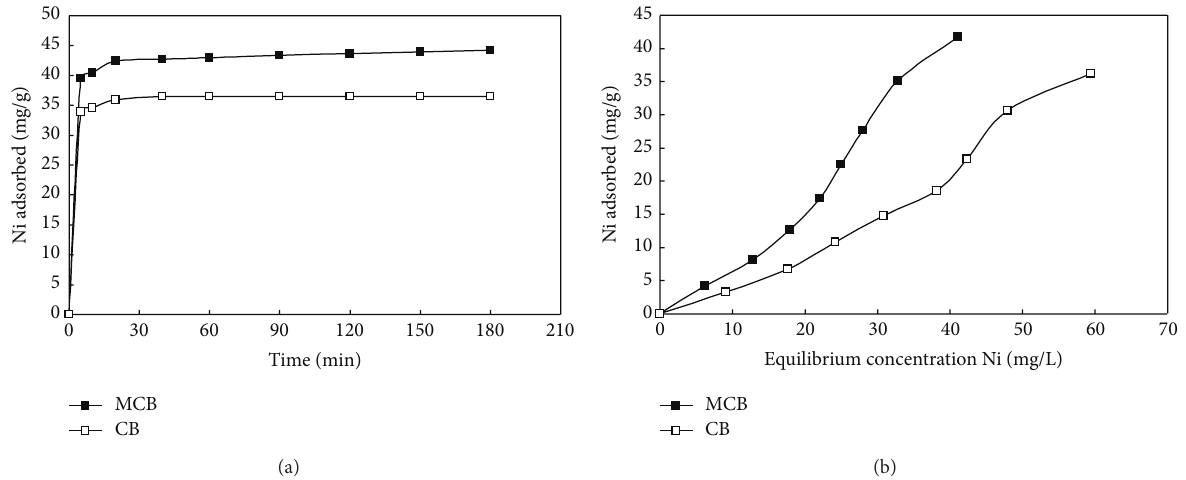
Figure 4: Adsorption kinetics (a) and adsorption isotherms (b) of Ni on MCB and CB at pH = 7.0 and 𝑇 = 25 ∘